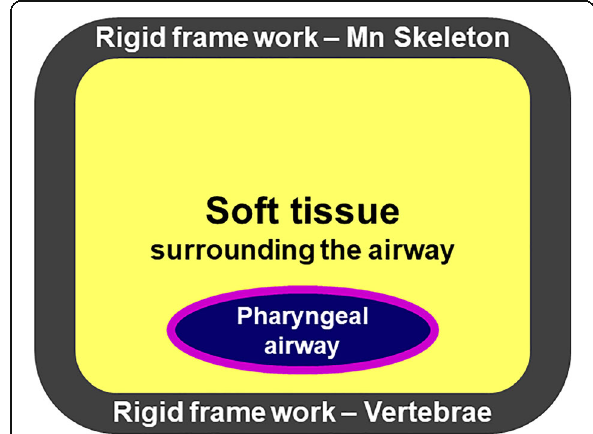
Fig. 1 Relationship between obesity and OSA. The mandibular skeleton or vertebrae can serve as a rigid framework. Increased fat accumulation at the pharyngeal airway can increase tissue pressure surrounding the pharyngeal airway. The lung volume may be decreased by excessive visceral fat deposition in the chest cavity between the vertebrae and